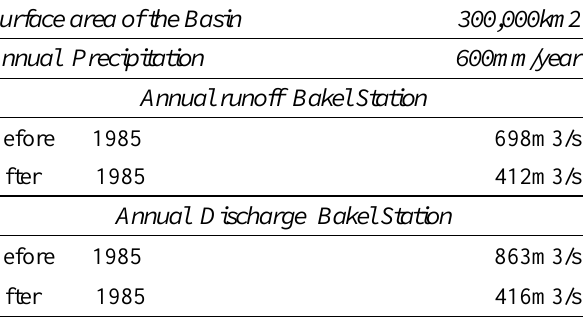
Table 1 : Hydrological characteristics of the Senegal River